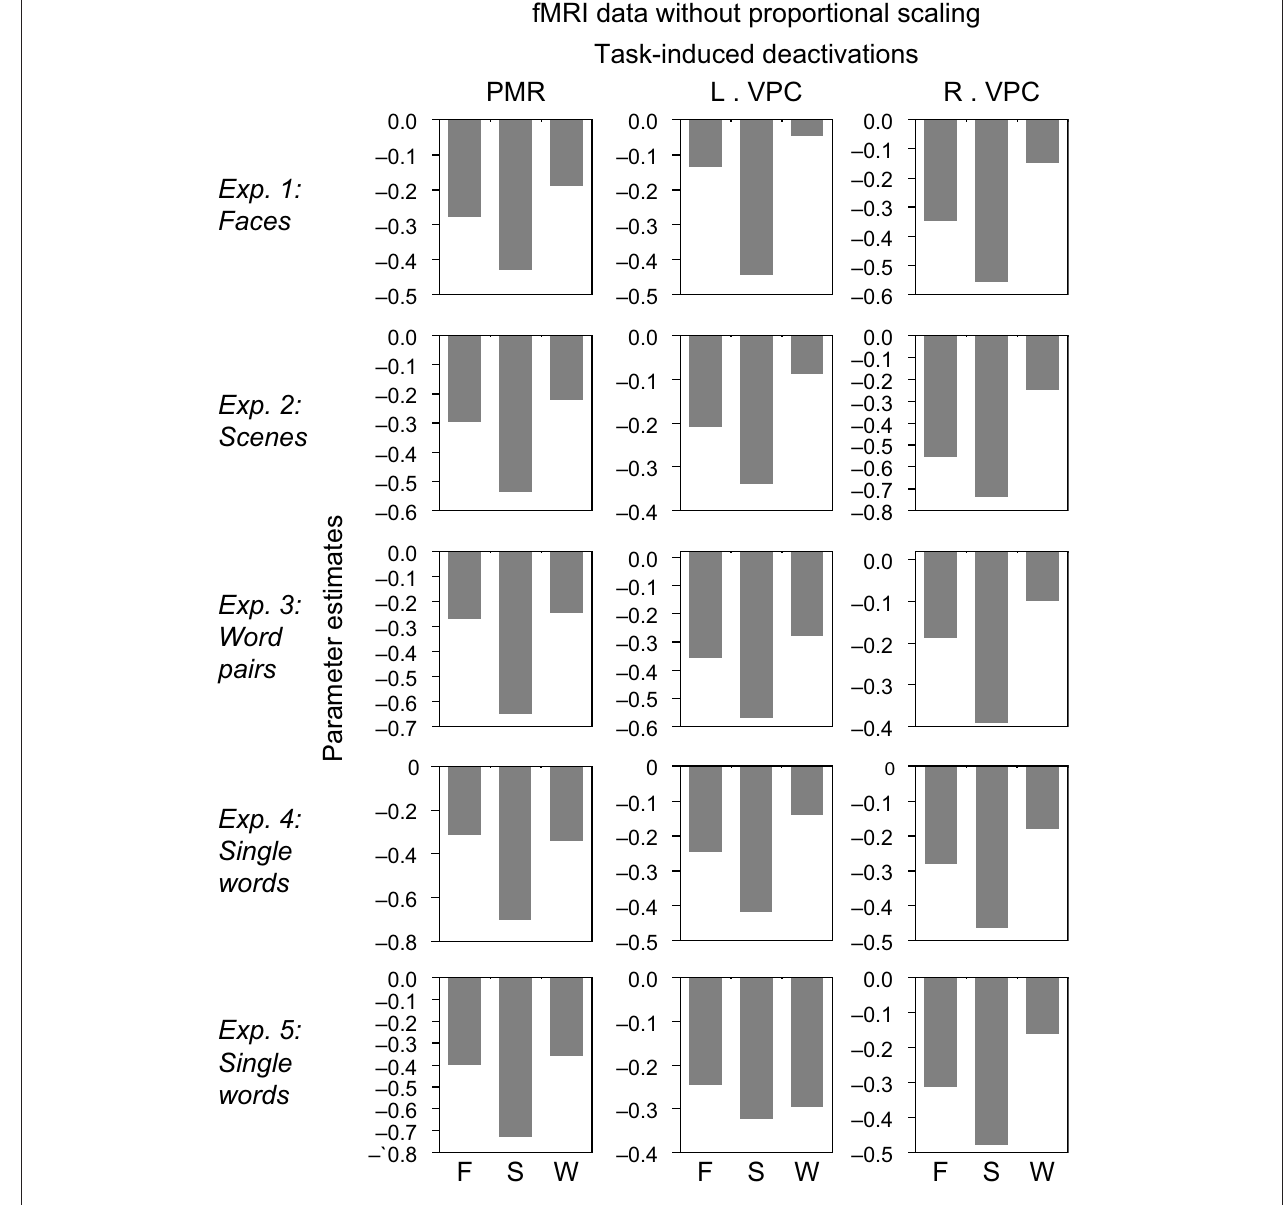
FIGURE 3 | Task-induced deactivations. The PMR and VPC regions identifi ed in Exp. 1–5 showed reliable task-induced deactivation during Blocked Task 1 (faces – F), Blocked Task 2 (scenes – S), and Blocked Task 3 (words – W). Bar graphs indicate mean cluster activity relative to the passive resting baseline.